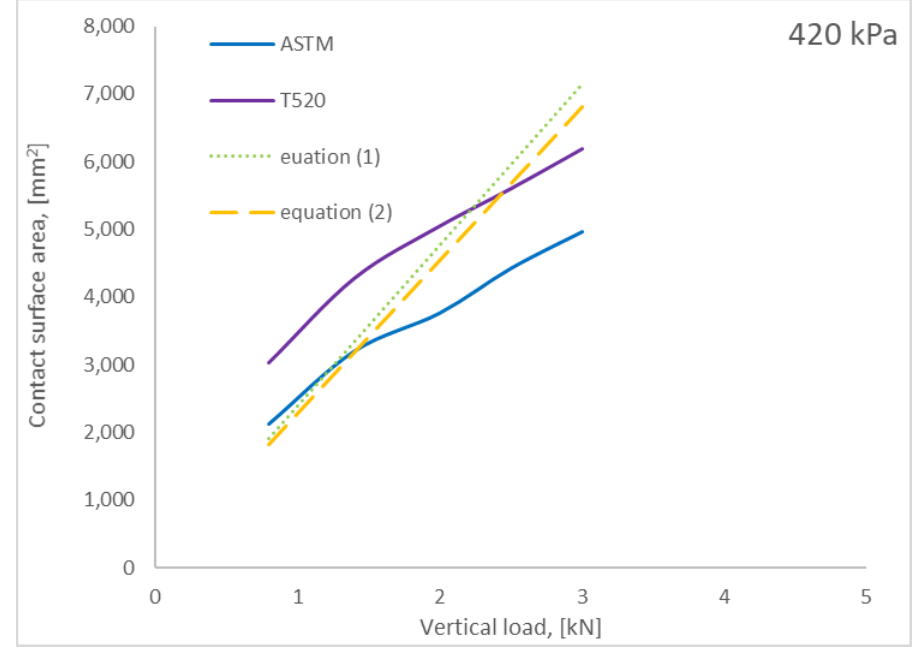
Figure 19. Contact surface area of the ASFT tires with surface, in relation to the load for wheel pressure of 420 kPa.